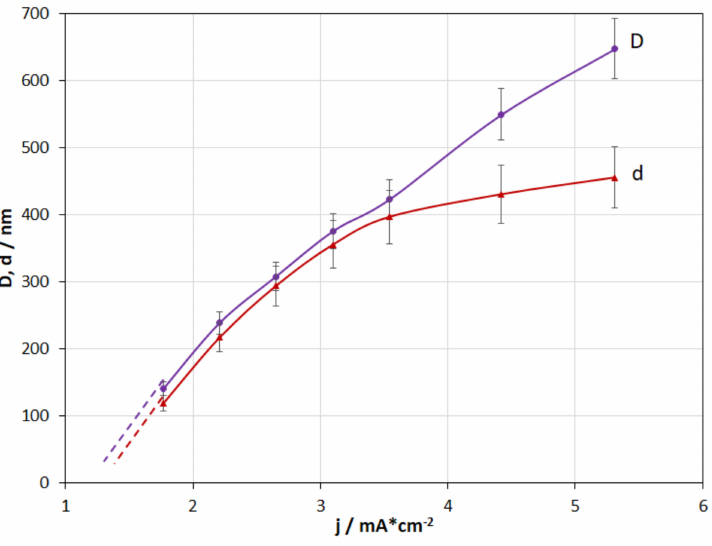
Figure 12. Dependence of the average coating thickness (D) and average particle size (d) on the current density (j).